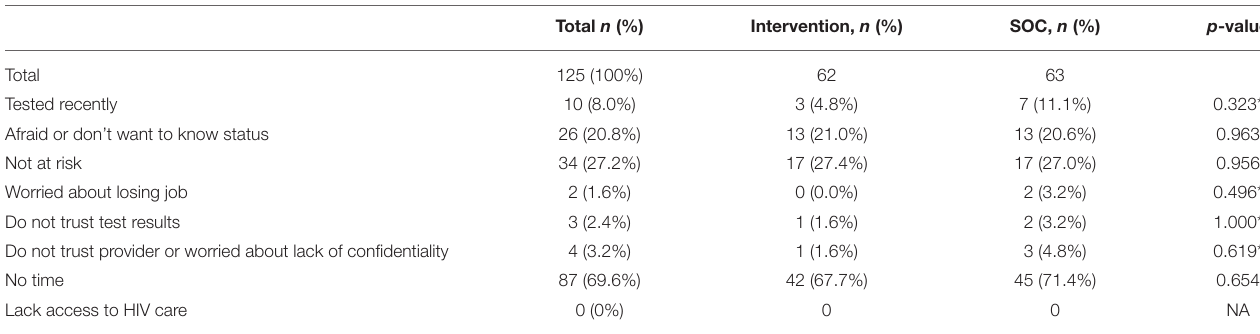
TABLE 1 | HIV test uptake overall and by arm under intent-to-treat and per protocol status. Total, n (%) Intervention arm, n (%) SOC arm, n (%) Mantel Haenszel Tested at 6 month follow-up (intent-to-treat